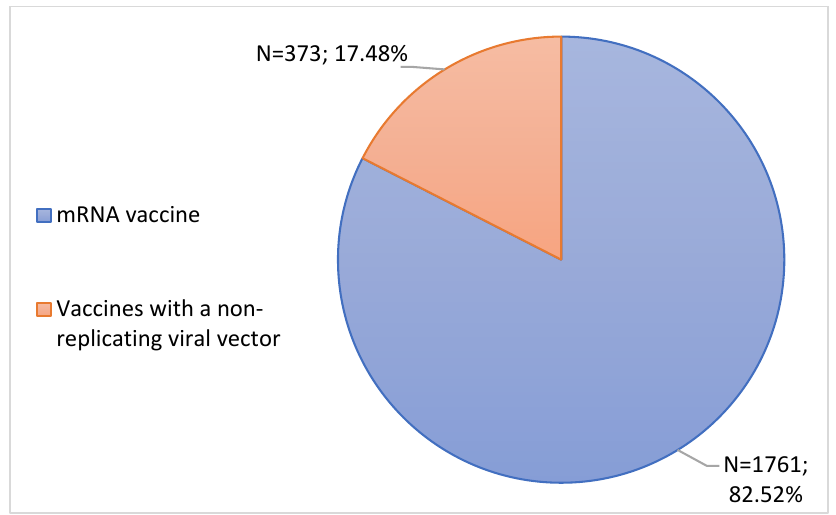
Figure 4. Characterization of notifications according to the type of vaccine.